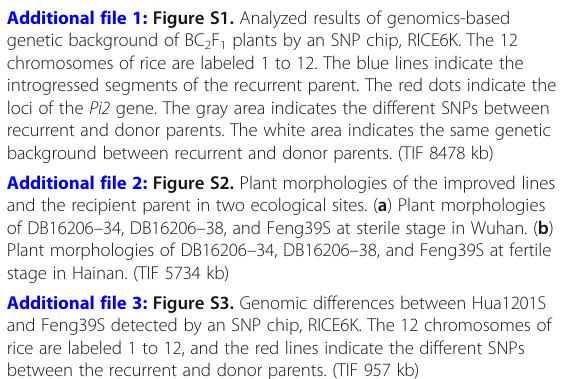
Additional file 1: Figure S1. Analyzed results of genomics-based genetic background of BC 2 F 1 plants by an SNP chip, RICE6K. The 12 chromosomes of rice are labeled 1 to 12. The blue lines indicate the introgressed segments of the recurrent parent. The red dots indicate the loci of the Pi2 gene. The gray area indicates the different SNPs between recurrent and donor parents. The white area indicates the same genetic background between recurrent and donor parents. (TIF 8478 kb) Additional file 2: Figure S2. Plant morphologies of the improved lines and the recipient parent in two ecological sites. ( a ) Plant morphologies of DB16206 – 34, DB16206 – 38, and Feng39S at sterile stage in Wuhan. ( b ) Plant morphologies of DB16206 – 34, DB16206 – 38, and Feng39S at fertile stage in Hainan. (TIF 5734 kb) Additional file 3: Figure S3. Genomic differences between Hua1201S and Feng39S detected by an SNP chip, RICE6K. The 12 chromosomes of rice are labeled 1 to 12, and the red lines indicate the different SNPs between the recurrent and donor parents. (TIF 957